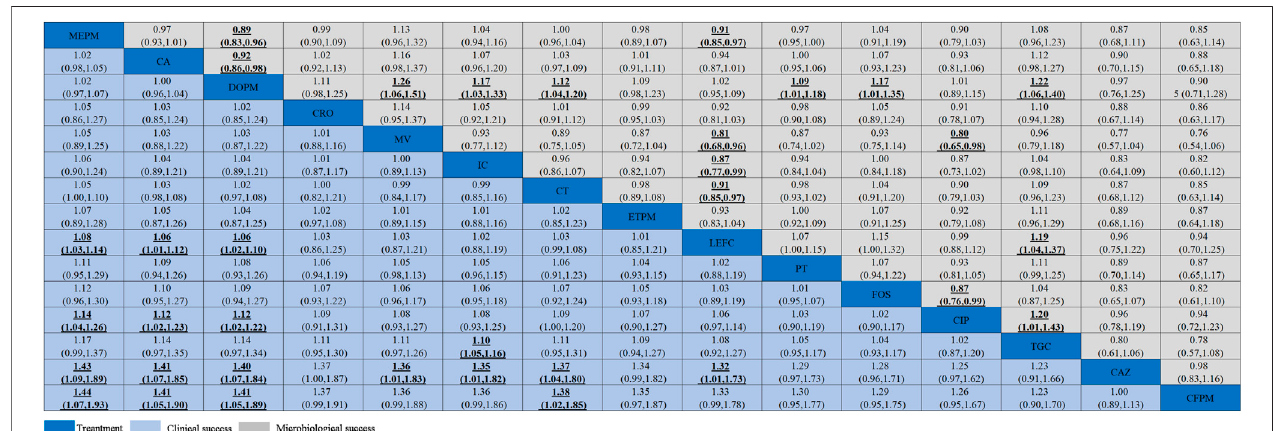
FIGURE 5 | Clinical success and microbiological success of interventions in the treatment of Enterobacteriaceae infections. Antibiotics were sorted in the order of decreasing clinical cure rate. The clinical success results were compared from left to right, and the microbiological success results should be read from right to left (the results were expressed by relative risk with 95% con fi dence interval). Signi fi cant results were shown in bold and underlined. CA, ceftazidime/avibactam; MV, meropenem/vaborbactam; MEPM, meropenem; DOPM, doripenem; IC, imipenem/cilastatin; CAZ, ceftazidime; CFPM, cefepime; CIP, cipro fl oxacin; PT, piperacillin/tazobactam; ETPM, ertapenem; LEFC, levo fl oxacin; FOS, fosfomycin; CT, ceftolozane/tazobactam; TGC, tigecycline; CRO, ceftriaxone.